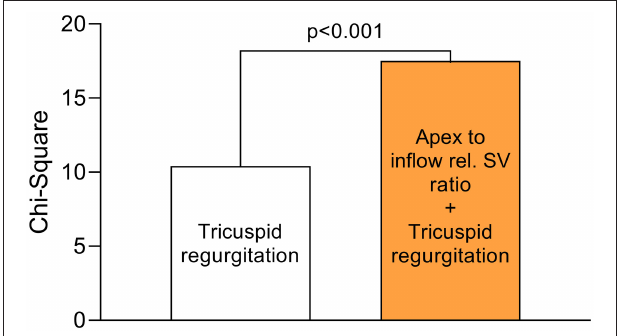
FIGURE 3 | Incremental value of apex to inflow rel. SV ratio over the presence of tricuspid regurgitation. In a multivariable logistic regression model ( n = 357) for the combined endpoint (in-hospital mortality/ECLS), apex to inflow rel. SV ratio added incrementally to the model over the presence of tricuspid regurgitation (grade ≥ 2). The chi-square values were compared using the omnibus test of model